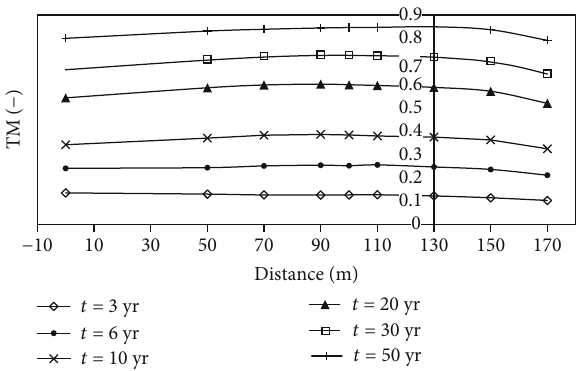
Figure 7: The calculated total solute mass (TM) in the domain with the high-permeability region ( k horizontal distances to the source zone